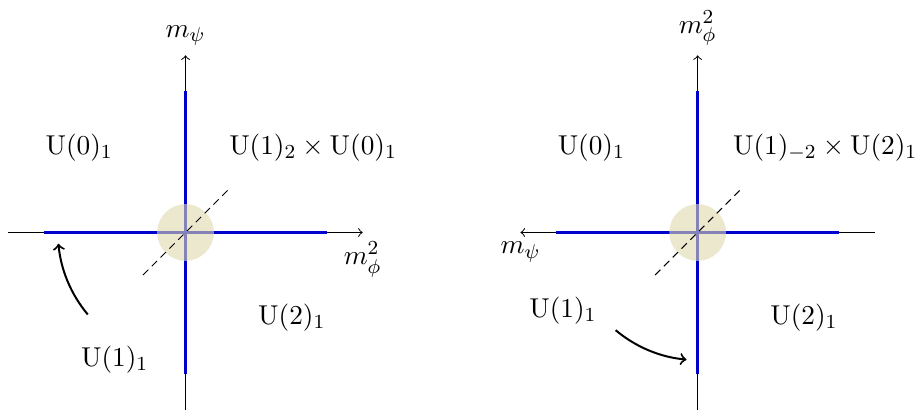
Figure 4 . U(1) 3 with φ, ψ U(1) − 3 with φ, ψ U(1) 1 . Phase diagram. We emphasized a / 2 / 2 ←→ × quantum time-reversal symmetry (with an anomaly) with respect to the dashed